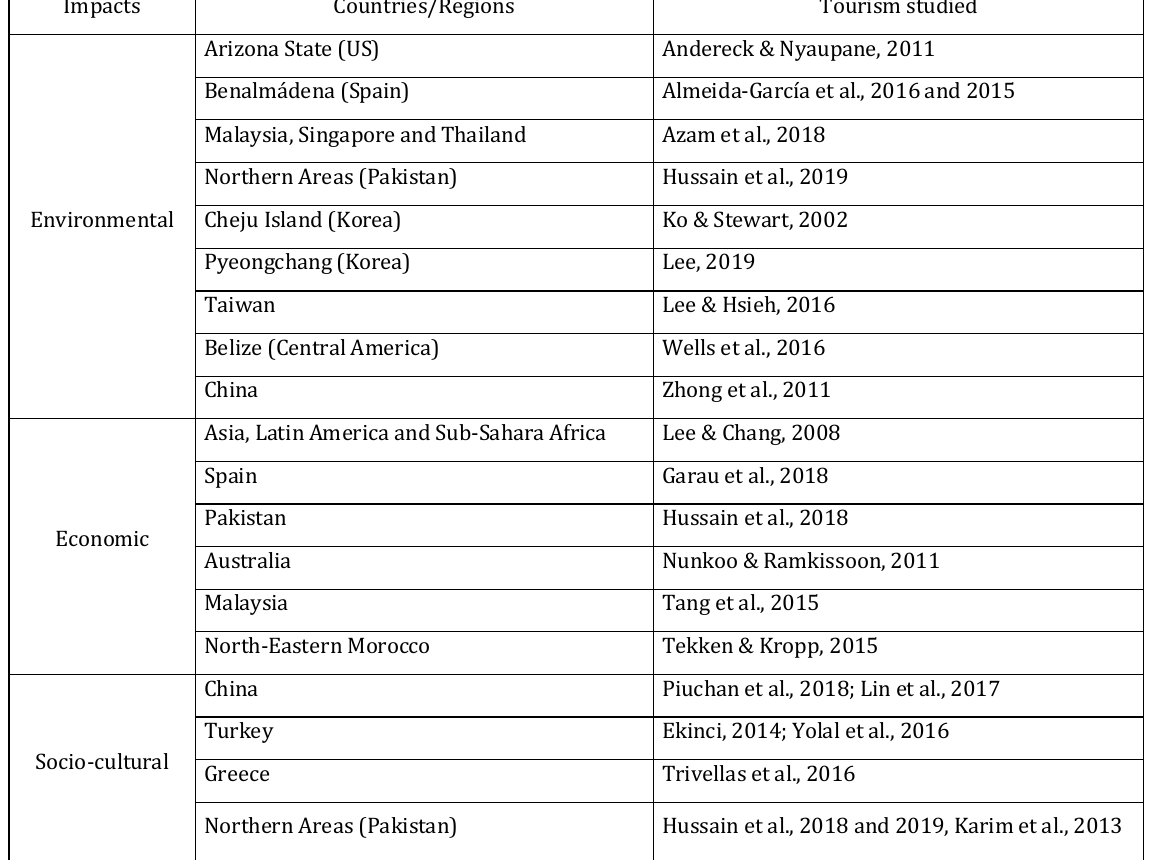
Table 1. Worldwide studies on the impacts of tourism by various researchers Impacts Countries/Regions